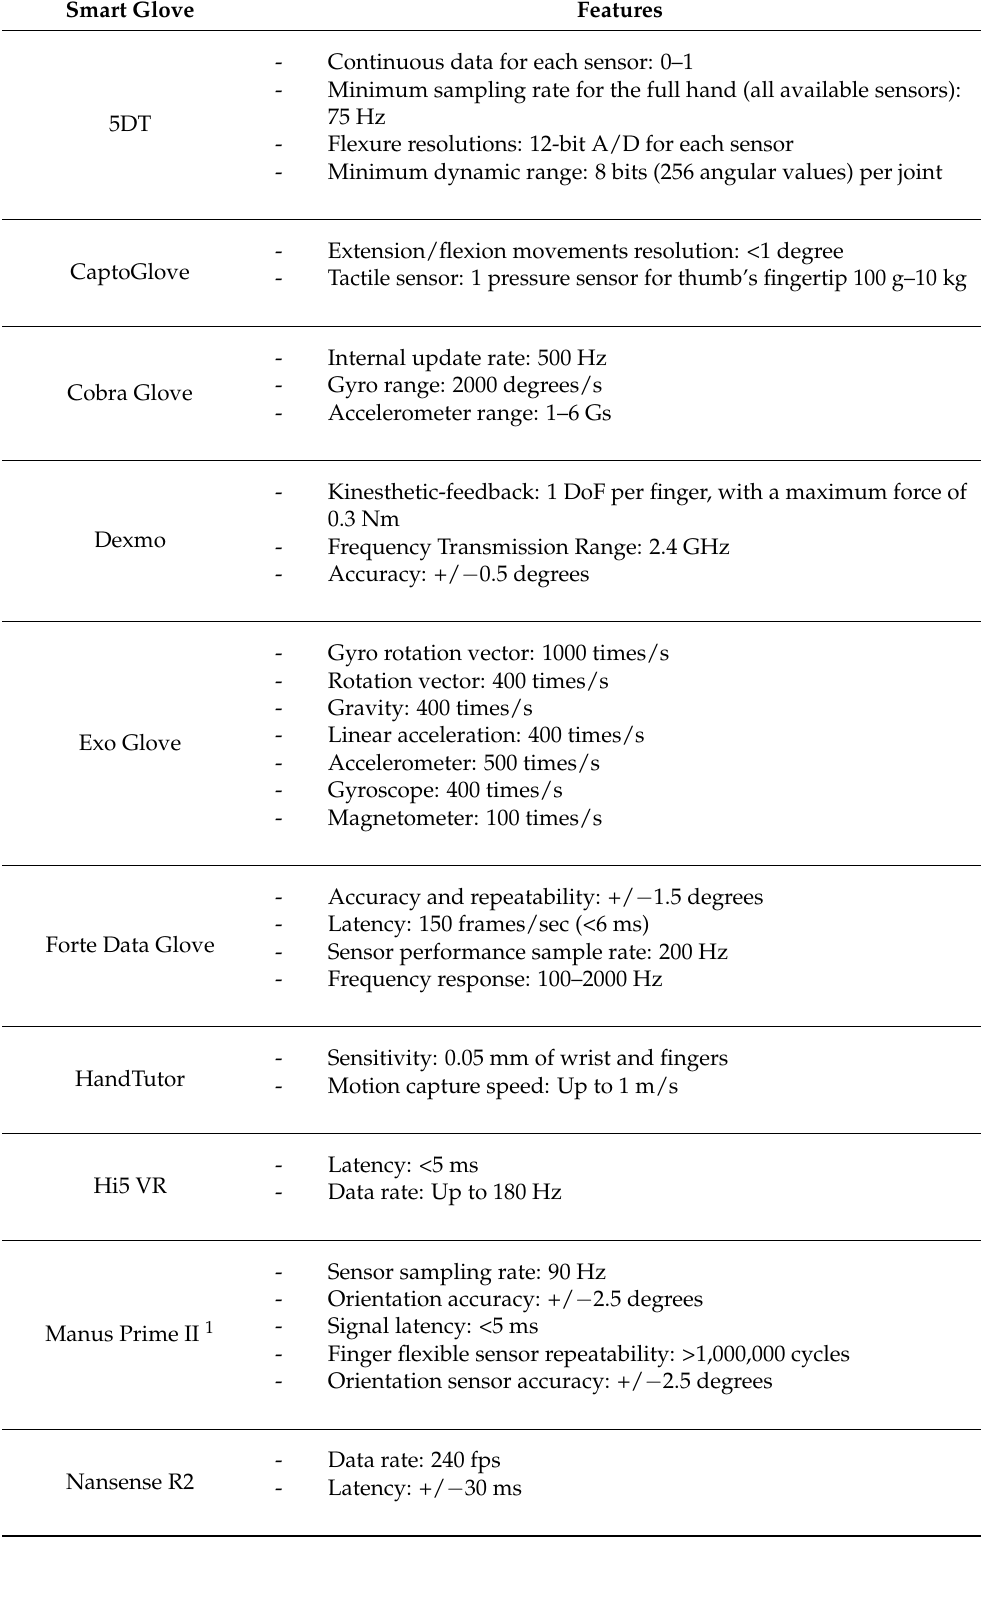
Table 9. Commercial smart gloves metrological